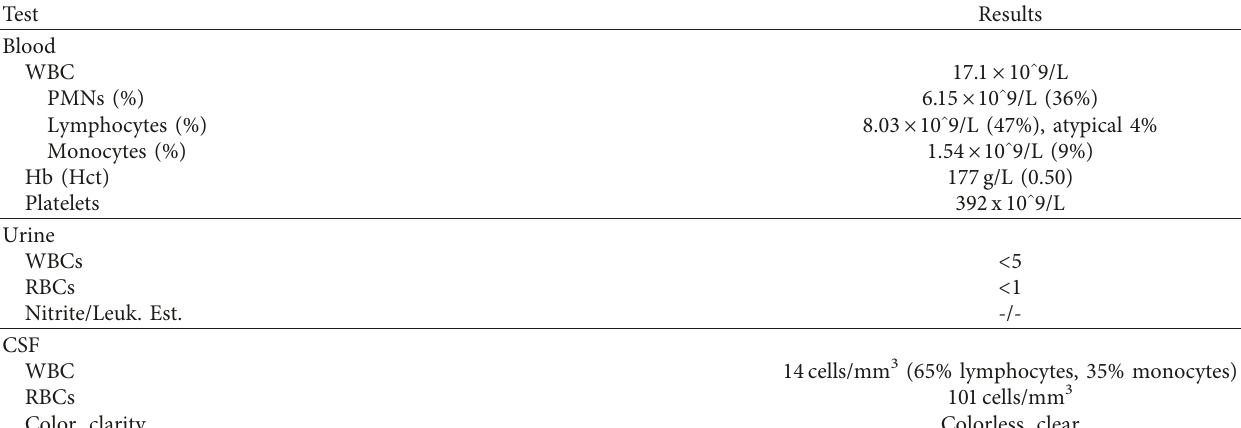
Table 1: Laboratory investigations performed at the time of admission.